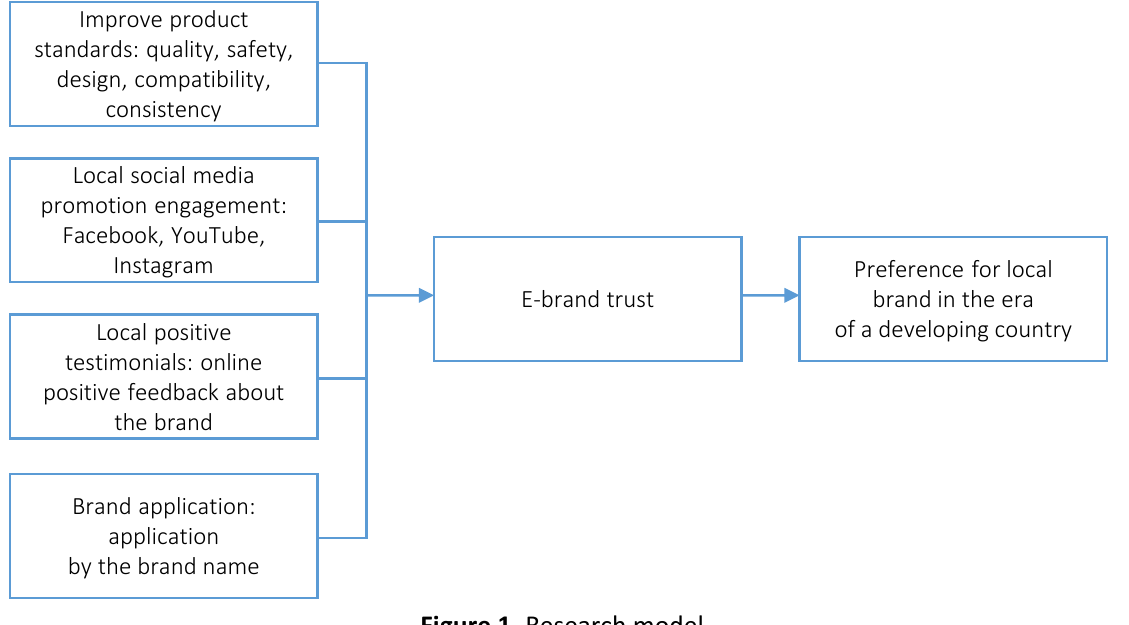
Figure 1. Research